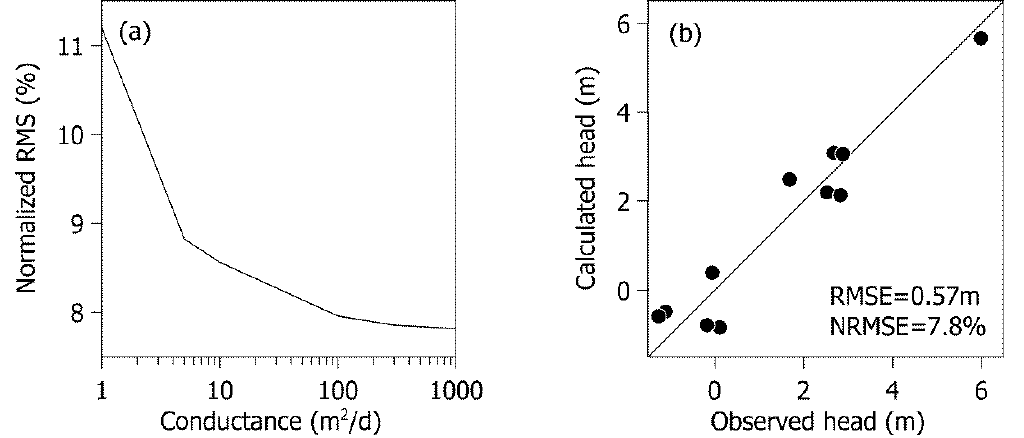
Figure 6. ( a ) Sensitivity analysis results of the conductance for river boundary condition and ( b ) comparison of calculated and observed groundwater levels in monitoring wells.